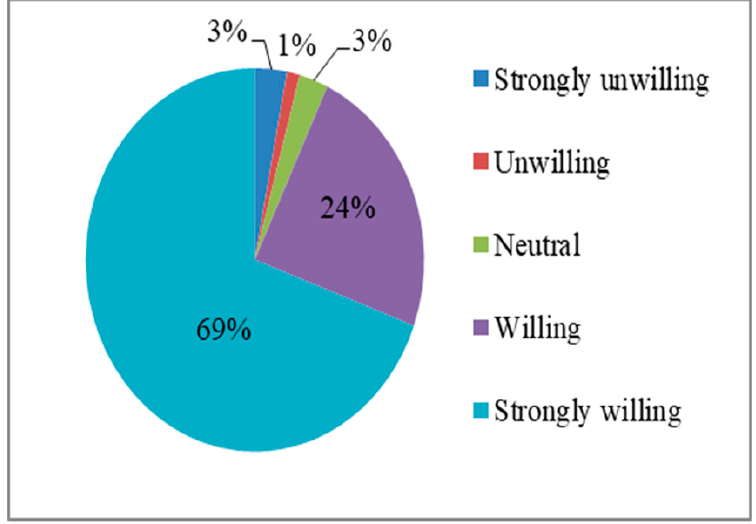
Figure 3. Frequency distribution map of residents’ evacuation willingness.